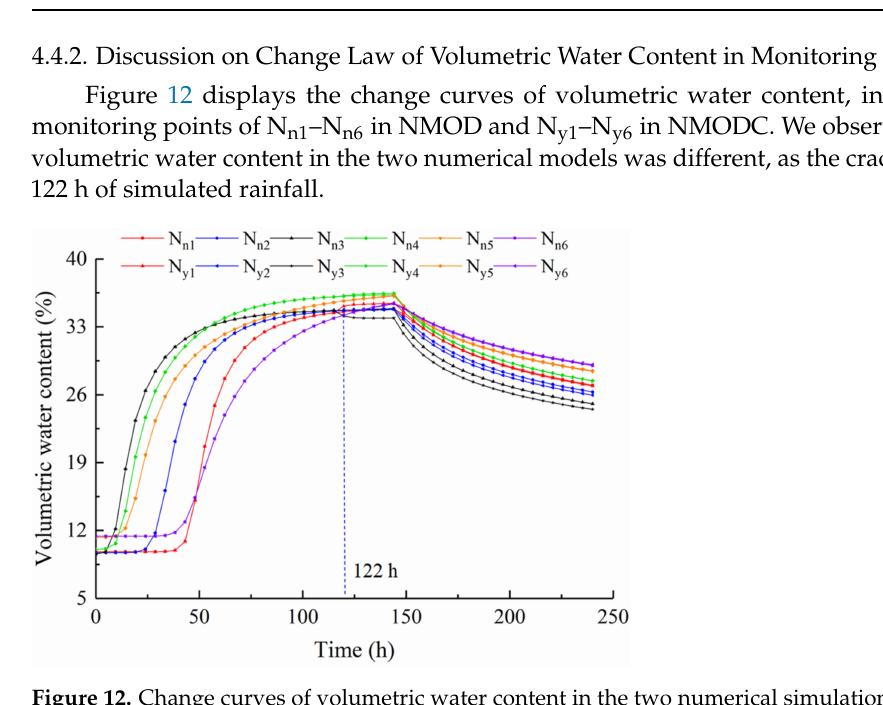
Figure 12. Change curves of volumetric water content in the two numerical